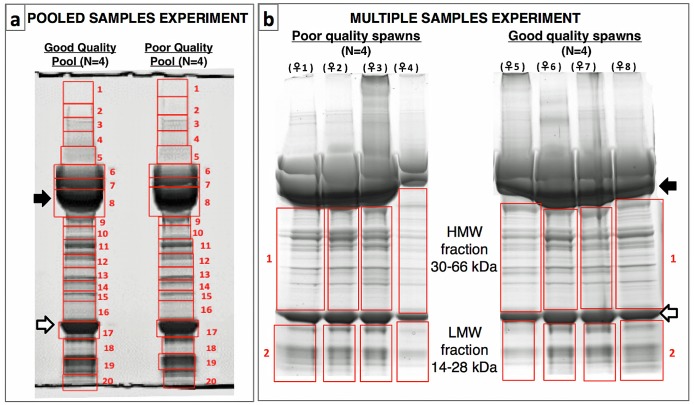
Sample fractionation prior to LC-MS/MS in the egg quality experiments.Panel a. Sample fractionation after SDS-PAGE in the Pooled Samples Experiment (N = 4 spawns per egg quality pool). Panel b. Sample fractionation after SDS-PAGE in the Multiple Samples Experiment (N = 4 replicate spawns per egg quality type). For each experiment, numbered frames in red indicate fractions excised from the gel and processed separately before submission to LC-MS/MS. Intact lipovitellin (Lv) heavy chain (closed arrows) and light chain (open arrows) were excluded in the Multiple Samples Experiment to better resolve other proteins. In total, 56 egg protein fractions were individually subjected to LC-MS/MS and downstream proteomic analyses. HMW; High molecular weight, LMW; Low molecular weight.